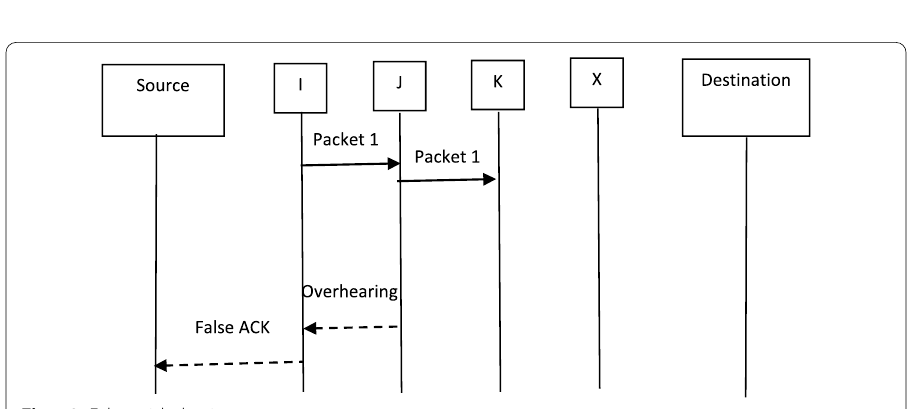
Fig. 9 Limited transmission power